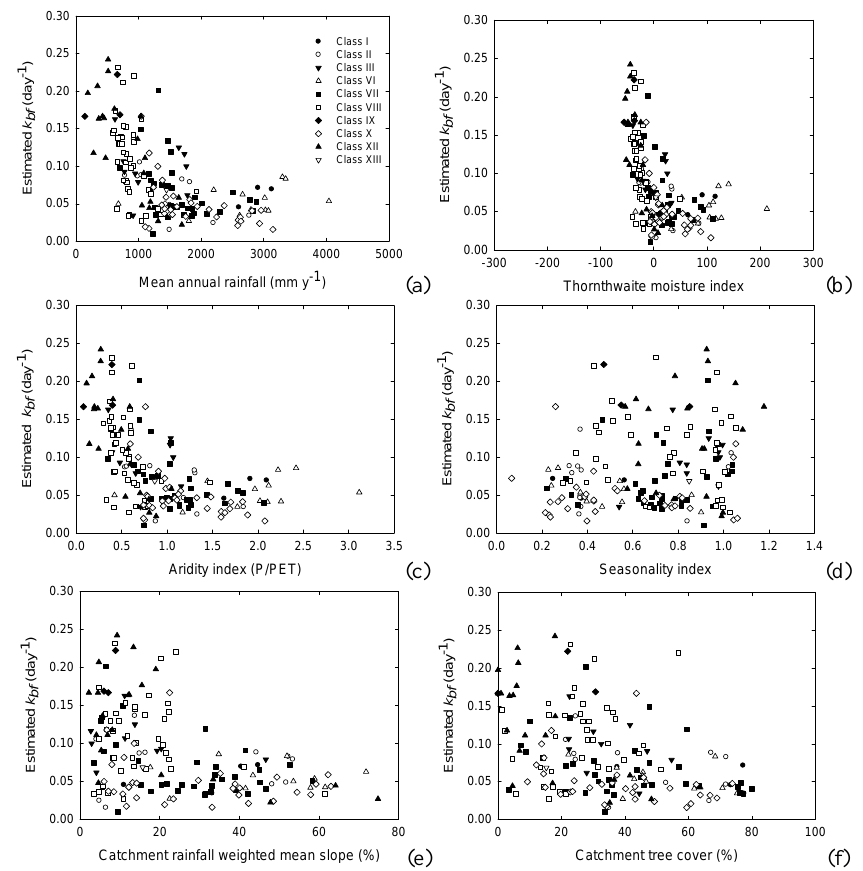
Figure 5. Scatter plots of recession coefficient k bf versus (a) MAR , (b) TMI , (c) AI , (d) SI, (e) 2 SLO and (f) TC . Symbols denote a proxy for aquifer drainage potential from WHYMAP 3 (2010). 4